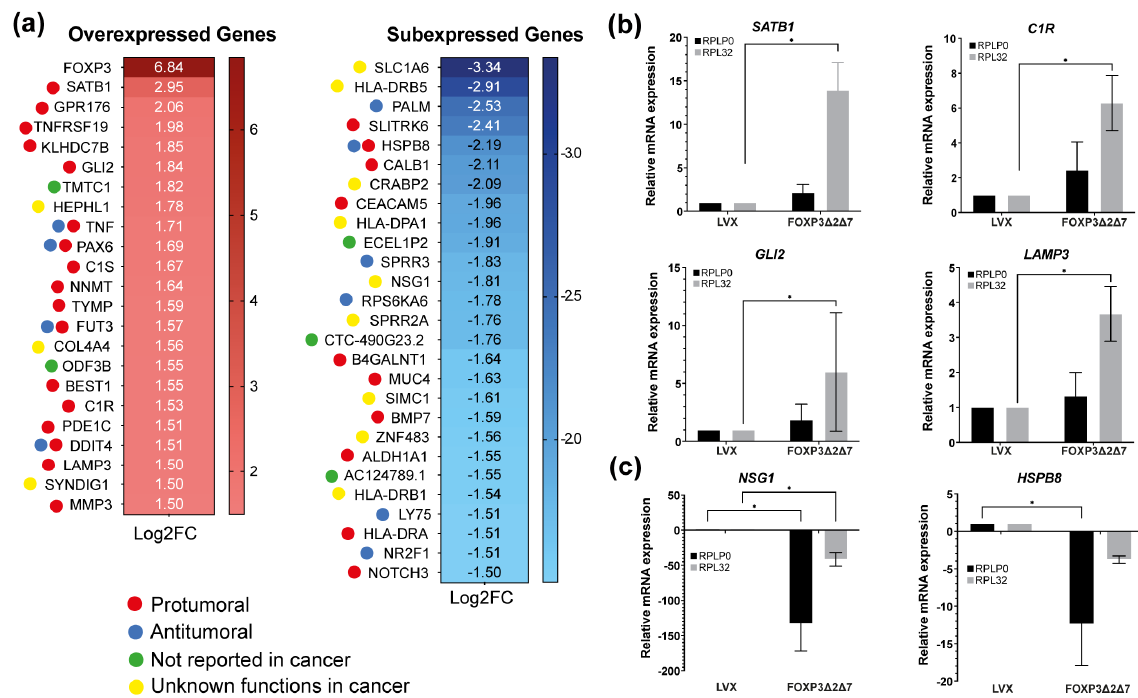
Figure 6. Identification of differentially expressed genes by FOXP3 Δ 2 Δ 7 exogenous expression. ( a ) Differentially expressed genes heatmap selected by − 1.5 ≤ Log2(fold change) ≥ 1.5, p -value < 0.05; code color indicates a review of what has been previously published about that gene; ( b ) relative mRNA expression of upregulated genes by qPCR; RPLP0 and RPL32 were used as reference genes; ( c ) relative mRNA expression of downregulated genes by qPCR; RPLP0 and RPL32 were used as reference genes. (*) depicts statistical significance with a p -value < 0.05.